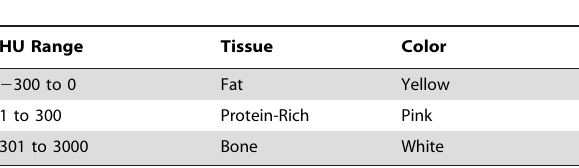
Table 1. HU Ranges for identified tissues.